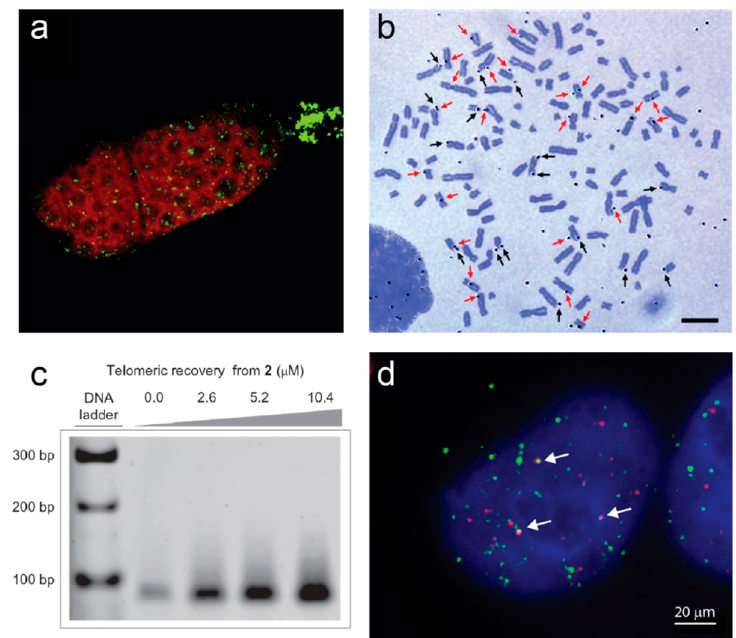
Figure 1. Examples of direct evidence for formation of G-quadruplexes at telomeres. ( a ) Immunofluorescence of a Stylonychia lemnae cell using an antibody raised against telomeric G-quadruplexes (green). DNA is counterstained in red; the replication band is the unstained region extending across the cell. Image from [35]. ( b ) Autoradiograph of metaphase spread of human T98G cells cultured with labeled G4 ligand 3 H-360A for 48 h. Black arrows indicate silver grains on the terminal regions and red arrows indicate silver grains on the interstitial regions. Bar = 10 µm. Image from [36]. ( c ) Pull-down of telomeric DNA from human HT1080 cells using the indicated concentrations of a derivative of G4 ligand pyridostatin attached to an affinity tag (2). Genomic DNA was sheared into 100–300 bp pieces prior to pulldown, and telomeric sequences detected by PCR amplification. Reprinted by permission from Springer Nature [37]. ( d ) Immunofluorescence of a human 293T cell using the BG4 antibody against G-quadruplexes (green) together with fluorescence in situ hybridization against telomeric DNA (red). Arrows indicate G4-telomere colocalizations. Image by A.L. Moye and T.M. Bryan.